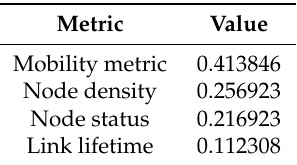
Figure 8. Path considered by source in analytical hierarchical process (AHP)-based multimetric geographical-routing protocol (AMGRP) and in GPSR to reach destination [35]. Table 3. Relative ranking of